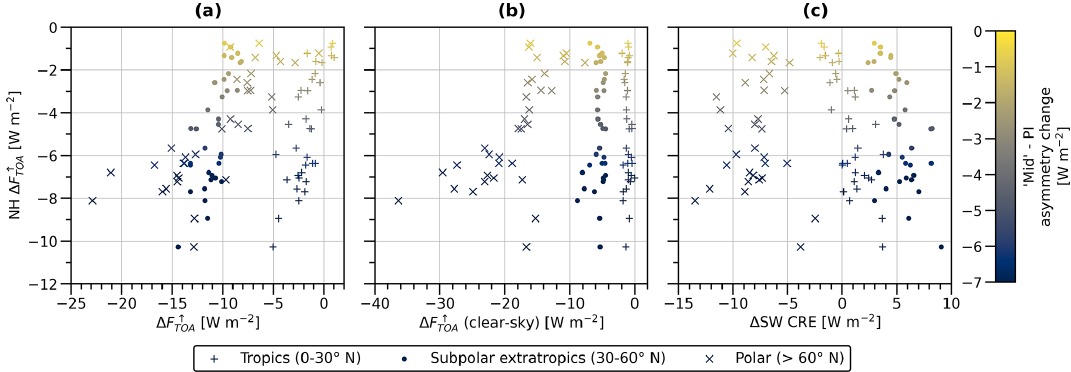
↑ , as well as (c) SW CRE, in three ranges of latitudes plotted against TOA